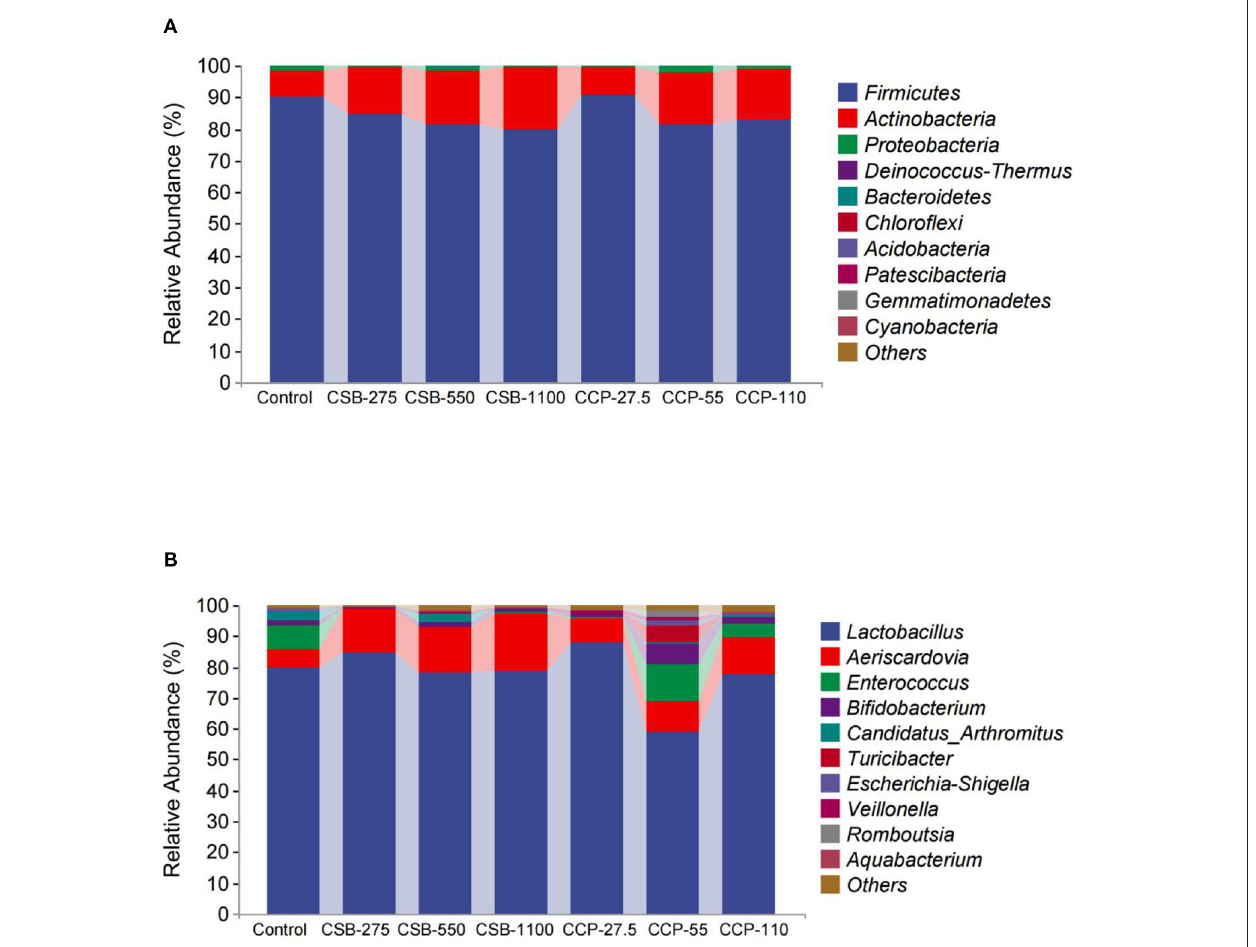
FIGURE 3 | Taxonomic classification of each group at the phylum and genus level: (A) phylum level; (B) genus level.